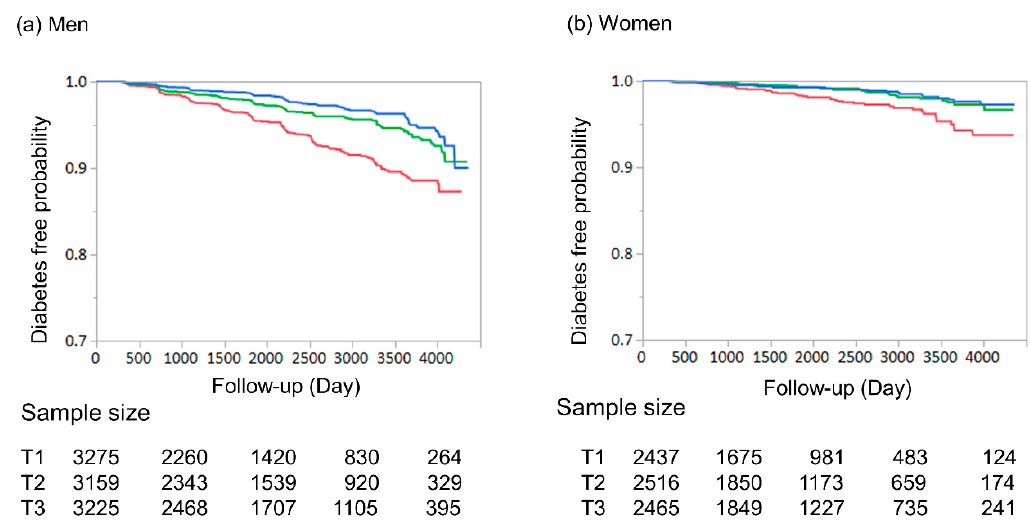
Figure 3. Kaplan–Meier analysis of incident diabetes according to the Cre / BW ratio tertiles. The vertical axis is diabetes free rate and the horizontal axis is time as months. ( a ) Kaplan–Meier analysis for incident diabetes in men. Red line indicates tertile 1 (Cre / BW ratio < 0.01275). Green line indicates tertile 2 (0.01275 ≤ Cre / BW ratio < 0.0148). Blue line indicates tertile 3 (Cre / BW ratio ≥ 0.0148). Log rank test was performed to investigate the association among the groups of Cre / BW ratio. Bonferroni correction was performed to correct familiar error and a p value < 0.0167 was considered statistically significant and all p values < 0.001. ( b ) Kaplan–Meier analysis for incident diabetes in women. Red line indicates tertile 1 (Cre / BW ratio < 0.0118). Green line indicates tertile 2 (0.0118 ≤ Cre / BW ratio < 0.014). Blue line indicates